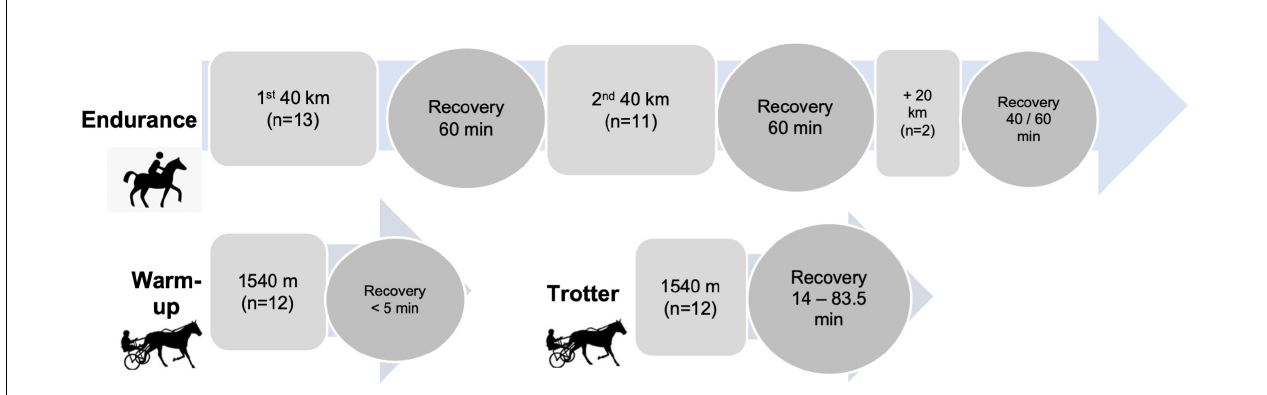
FIGURE 1 | Flow chart of study design describing two types of exercise and distance; km, kilometers; m, meters; n, number of horses; min, minutes; endurance exercise; moderate trotter warm-up exercise; and fast trotter